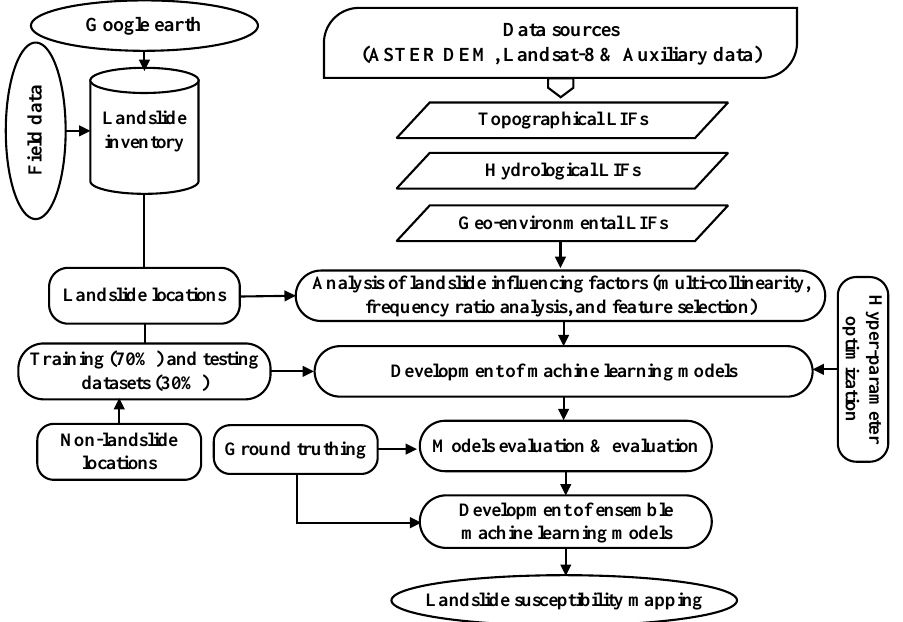
Figure 3. A workflow diagram of the overall methodology adopted in LSM.